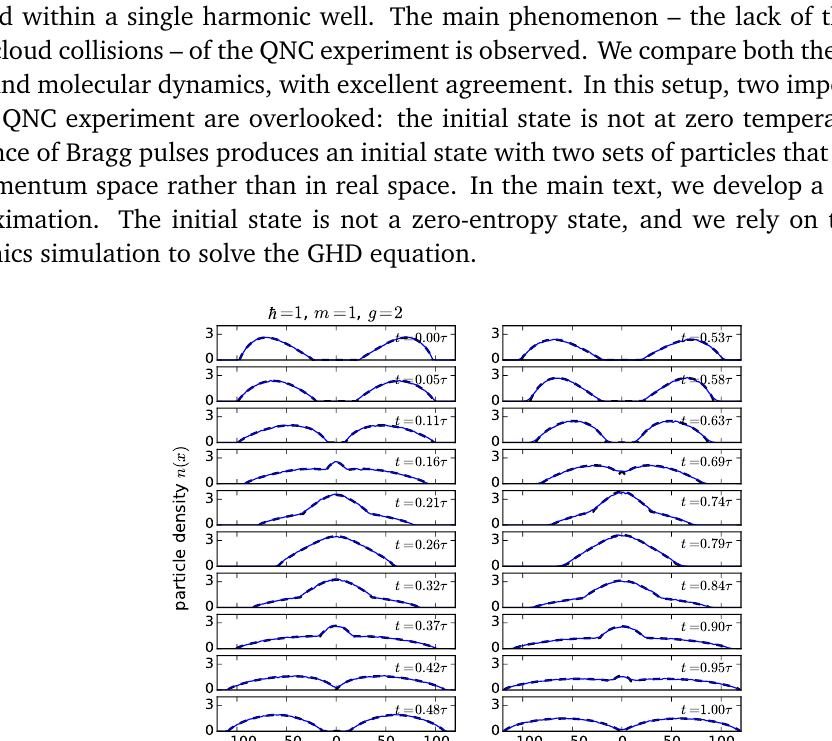
π ω , for parameters